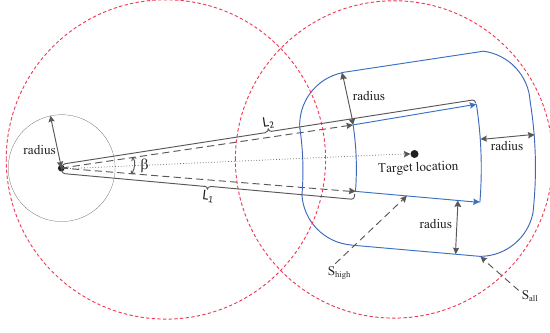
Figure 4. User Location and Target area. Table 1. Positioning system performance